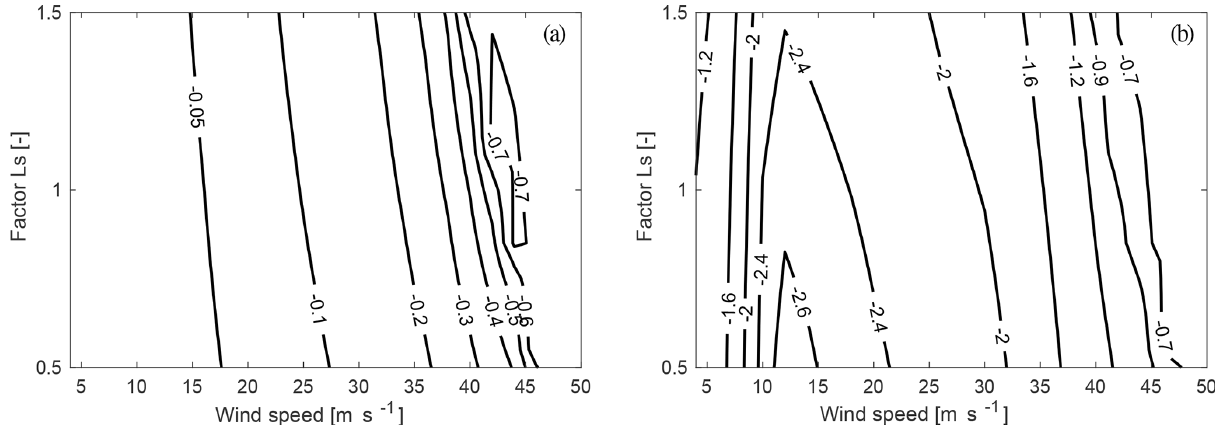
Figure 12. Real part of the first (a) and second (b) eigenvalue of the yaw mode for a variation in shaft length and wind speed from the 2-DOF